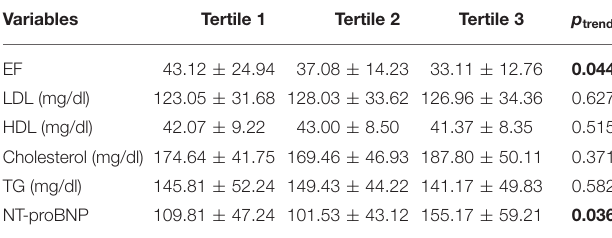
For abbreviations, see Table 1 . Values are presented as mean ± SD for variables with normal distribution or median (interquartile) for variables without normal